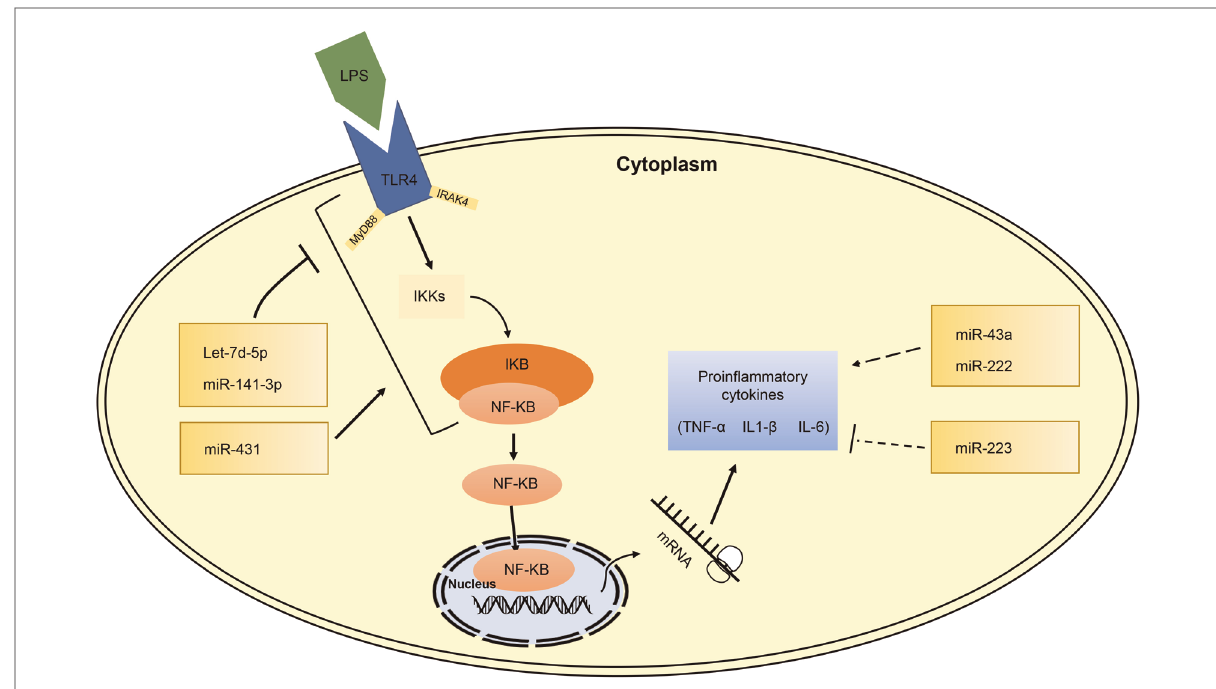
Figure 4 miRNA dysregulation of in fl ammatory process in NEC pathogenesis.